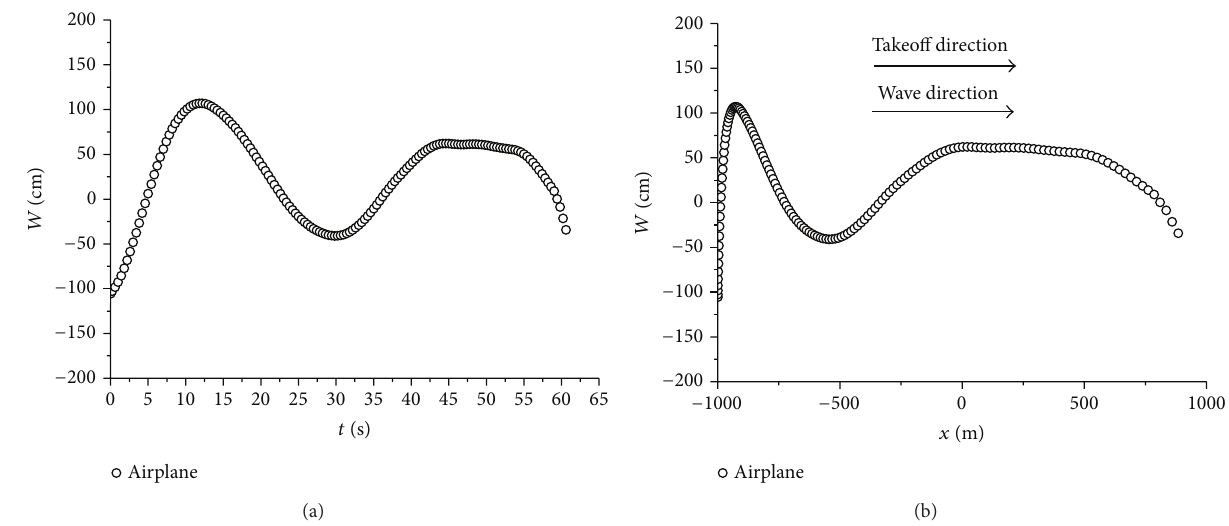
histories of the vertical displacement and the locations of the airplane stay always at the bottom of sunken deflections of the runway during landing or takeoff run. However, in the following wave conditions, the displacement magnitude of the runway is greater than that only induced by airplane though the airplane weight reaches about 3900 kN, and the deflections of the runway due to the presence of airplane can be ignored. The airplane can surf on a series of progressive waves when the speed of airplane is closer to the one of structural